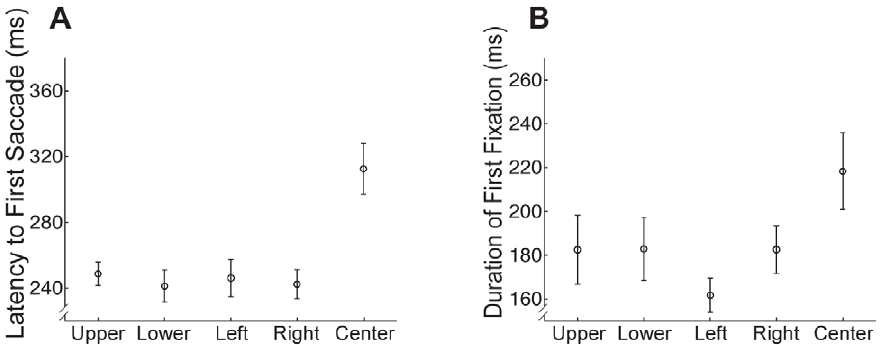
Figure 5. Impact of start position on timing of initial saccades and fixations for upright faces. ( a ) Average latency to first saccade by start position. Note the longer delay between face onset and the first saccade for the center compared to peripheral start positions. ( b ) Average duration of first fixation by start position. Note the longer fixation duration for the center compared to peripheral start positions. All error bars indicate the between-subjects standard error.